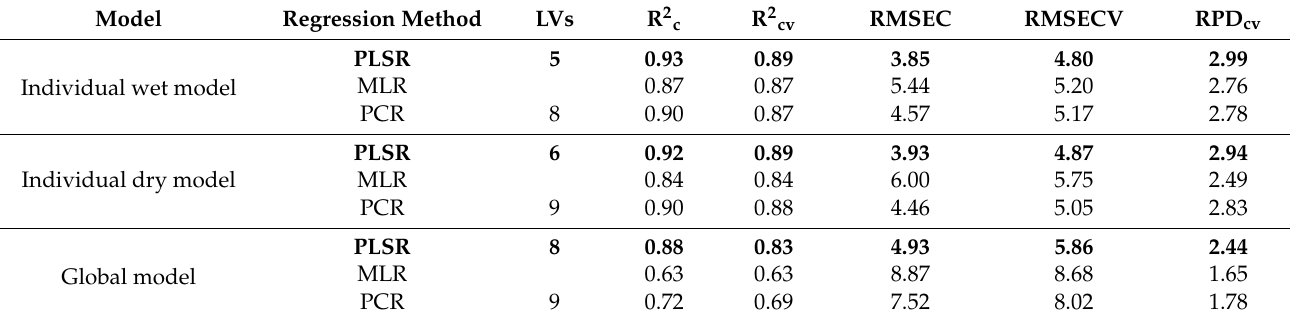
Table 3. Model development results for adulteration quantification using partial least square regression (PLSR), multiple linear regression (MLR), and principal component regression (PCR) with the individual and combined sample set using pre-processed spectra (MAS + SNV + SG1d). The best model for each regression method is highlighted in bold. The RMSEC and RMSECV were expressed in % ( w / w